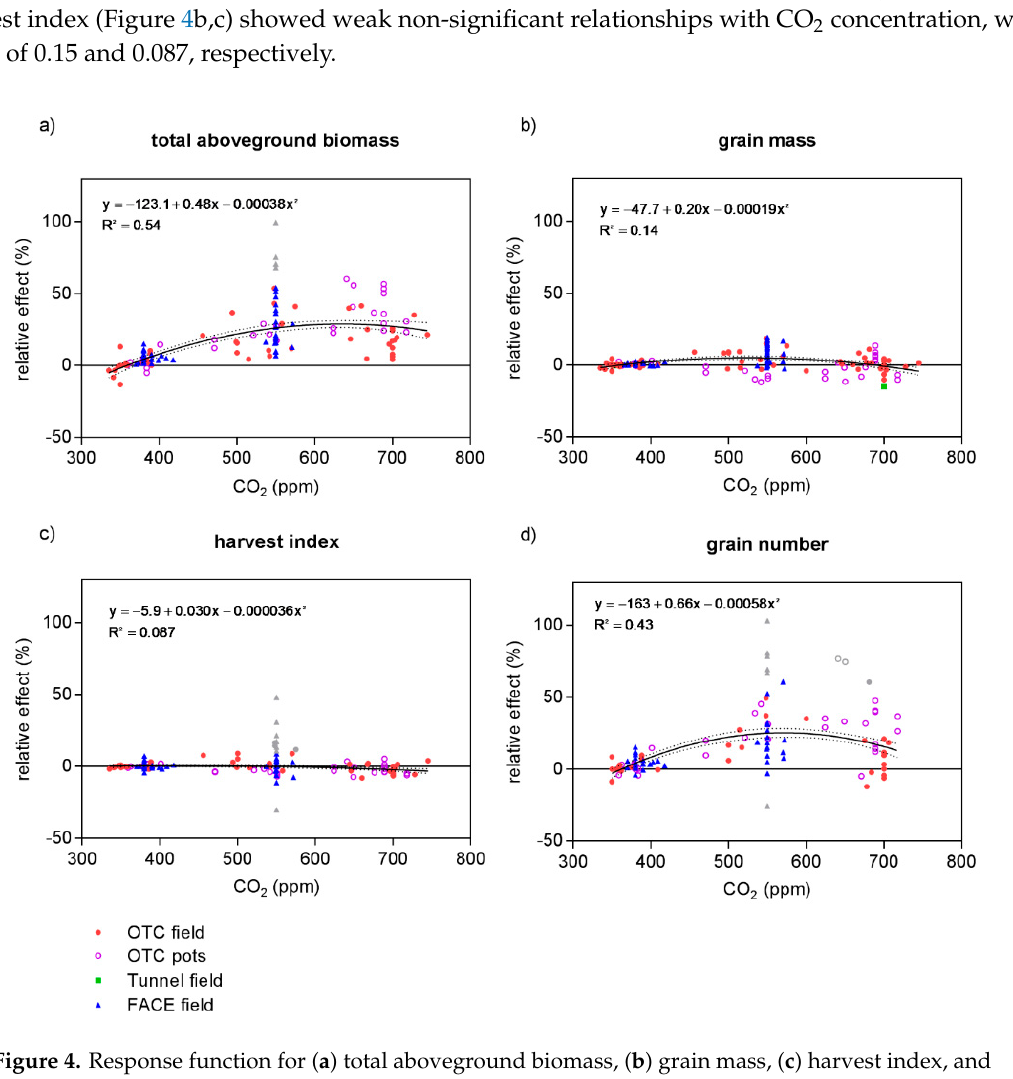
The broken line (1:1-line) represents the theoretical situation where the effect of eCO 2 on grain yield is entirely explained by the effect on grain number. The slope of the regression line ( y = 6.58 + 0.90 x ) was not significantly different from the 1:1-line ( p = 0.20).